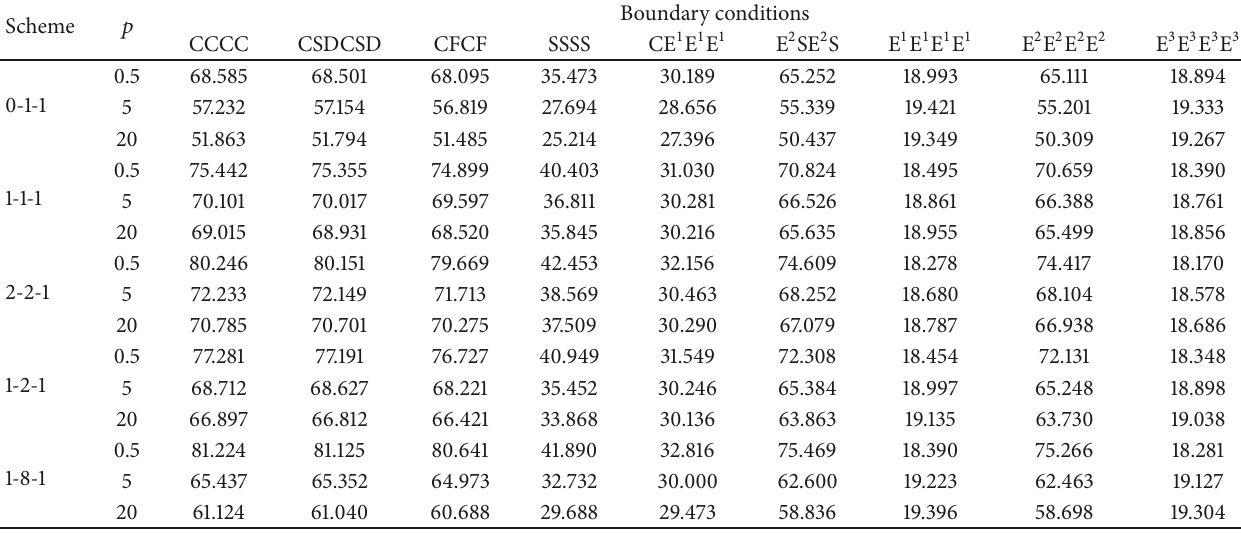
Table 7: Fundamental frequency parameter Ω for Type 2-1 annular sector plate with various boundary conditions ( 𝑅 0 /𝑅 1 = 0.5, ℎ/𝑅 1 = 0.2, 𝑝 1 = 𝑝 3 = 𝑝 , and 𝜙 = 240 ∘ ). Scheme